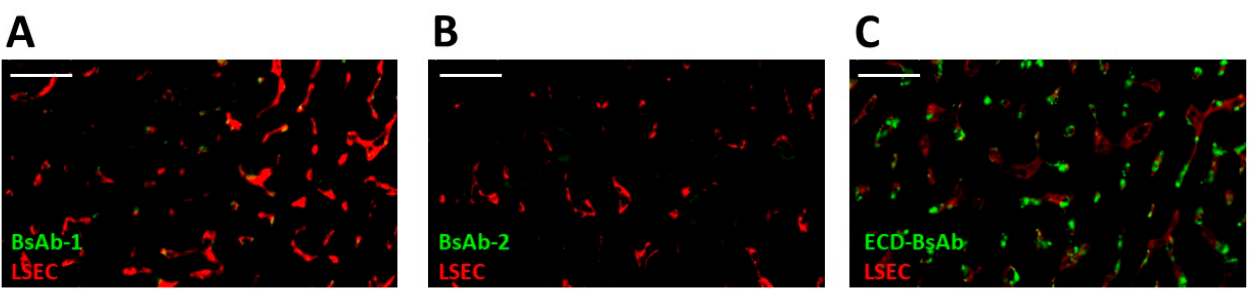
Figure 4. Immunofluorescence of BsAb-1, BsAb-2 and an ECD-based BsAb in cynomolgus monkey liver following a single IV administration of each molecule. In each panel green and red represent detection of the BsAb (using an anti-human (IgG) and LSECs (via detection of the endothelial cell marker CD31 PECAM1), respectively. Immunofluorescence detection of ( A ) BsAb ‐ 1 ( B ) BsAb ‐ 2 and ( C ) ECD ‐ based BsAb (used as a positive control from a previous study) [13]. Data are from representative liver sections from a single cynomolgus monkey. The scale bars represent 50 um.